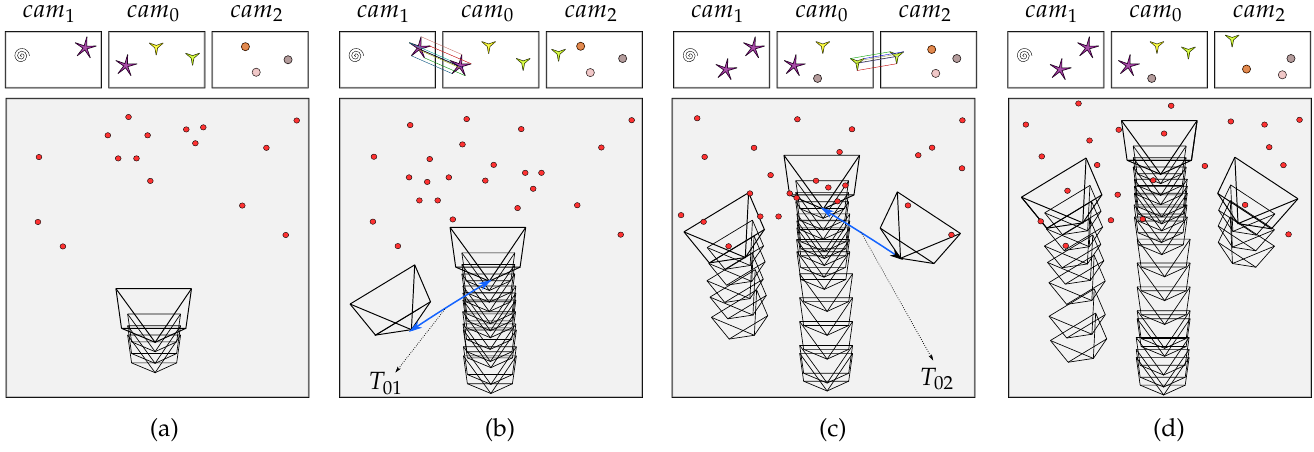
Figure 3. Multi-camera initialization of the system. Each subfigure consists of a big box which represents the sparse map and three small boxes which represent the current frames of corresponding cameras. The sparse map includes the keyframes (pyramids) and the map points (red). ( a ) First, the map is initialized with the reference camera. ( b , c ) In order to localize other cameras, we search for ORB correspondences between the reference keyframe and the current frame. Finally, we localize the other cameras and calculate the relative poses (blue). ( d ) Multi-camera initialization is